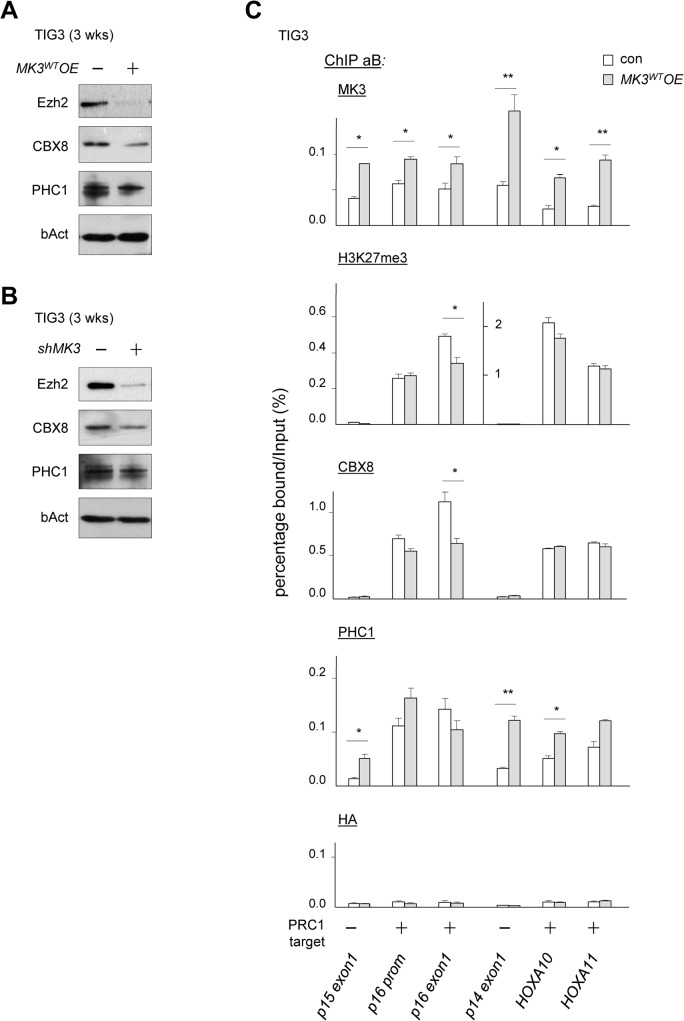
Functional links between MK3 and PRC in proliferative life span.(A) Expression levels of the PRC proteins EZH2, CBX8 and PHC1 in senescing TIG3/MK3
WT
OE cells at ±3–4 weeks post-transduction; loading control b-Actin (bAct). (B) Expression levels of the PRC proteins EZH2, CBX8 and PHC1 in senescing TIG3/shMK3 cells at ±2–3 weeks post-transduction; loading control b-Actin (bAct). (C) Chromatin immunoprecipitation (ChIP) analysis of MK3, H3K27me3, CBX8, PHC1 enrichment in MK3
WT
OE (MK3
WT
OE) expressing and control (con) TIG3 cells; PRC1-target loci (p16 promoter, p16exon1, HOXA10, HOXA11) and non-target loci (p15exon1, p14exon1) are indicated below the figure. Enrichments are presented as percentages of total input. Negative control HA antiserum. Experiments were performed three times; results of one representative experiment are shown (statistical significance: * p<0.05, ** p<0.01; t-test).